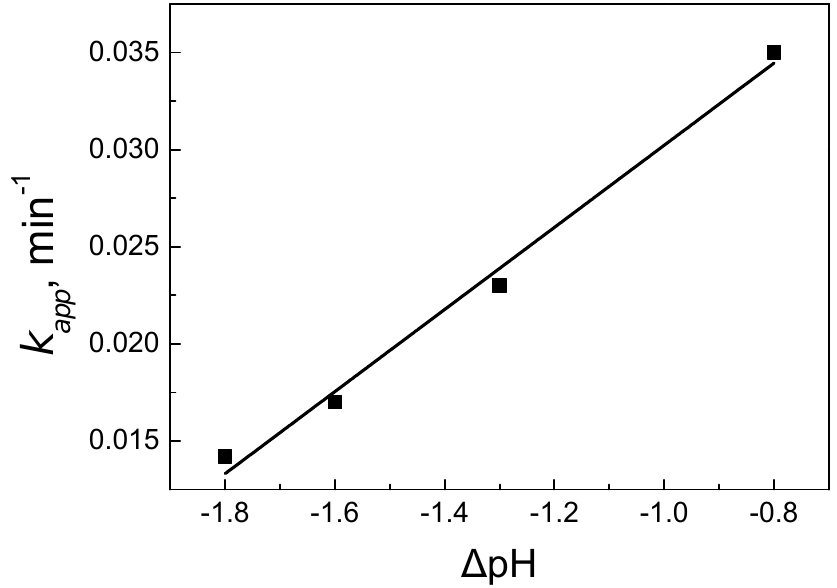
Figure 7. Linear correlation between k app of the biochars at inherent pH with the pH difference between adsorption and oxidation processes.